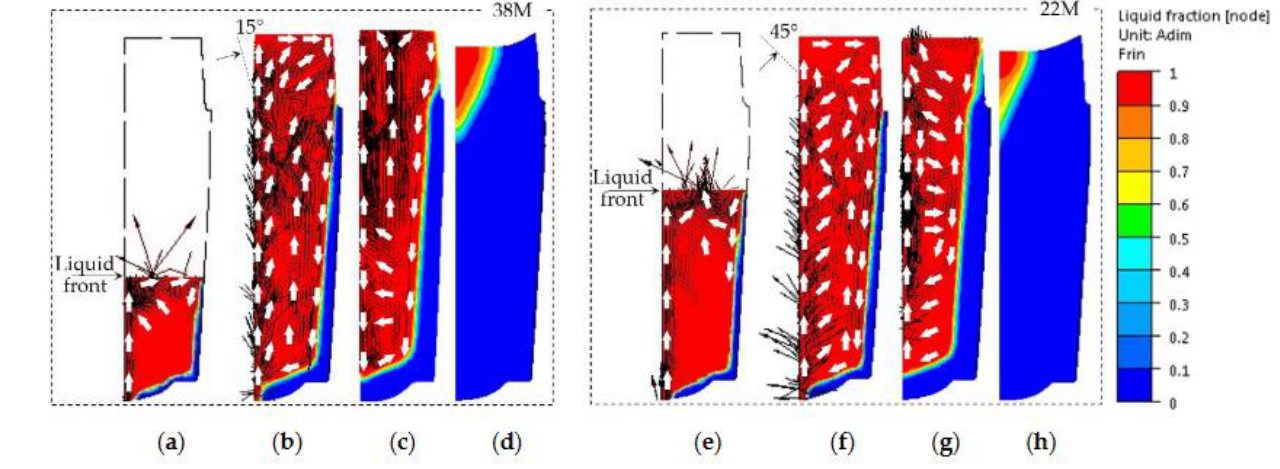
Figure 4. Liquid fraction patterns combined with velocity vectors predicted by 38 M and 22 M for times of: ( a , e ) 12 min; ( b , f ) end of filling; ( c , g ) 1.5 h; ( d , h ) 10.5 h.